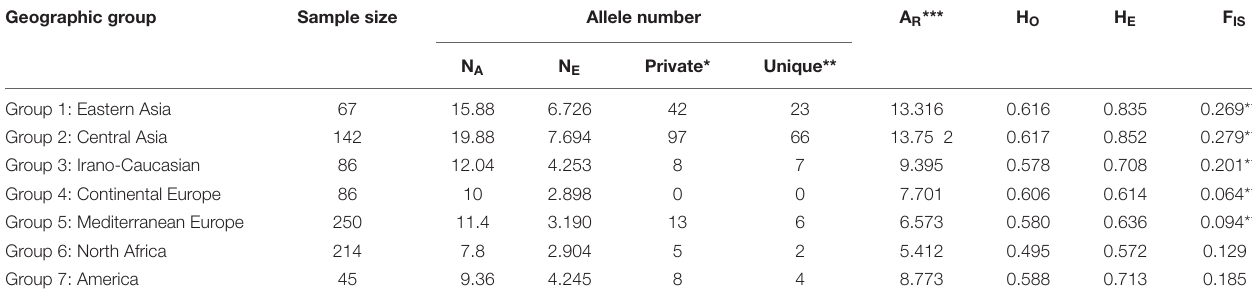
TABLE 2 | Comparison of genetic diversity generated by 25 SSR markers within the seven geographic apricot groups. Geographic group